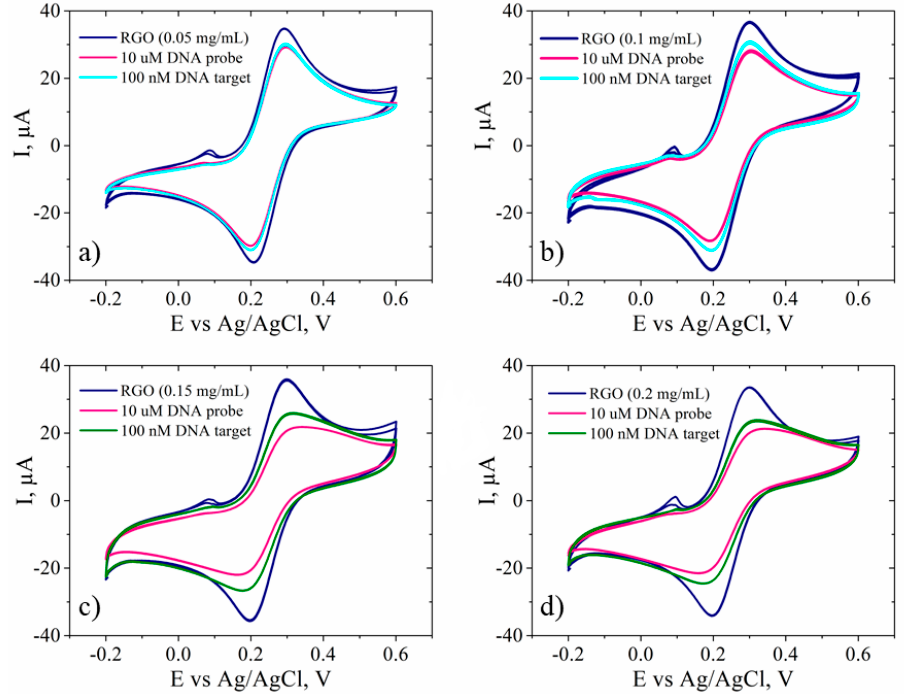
Figure 10. CV measurements recorded in 1 mM [Fe(CN) 6 ] 3 − /4 − , 0.1 M KCl, for RGO-SPCEs based on ( a ) 0.05 mg/mL; ( b ) 0.1 mg/mL; ( c ) 0.15 mg/mL; and ( d ) 0.2 mg/mL GO dispersions, after adsorption of ssDNA probe (10 µM) and hybridization with 100 nM DNA target.